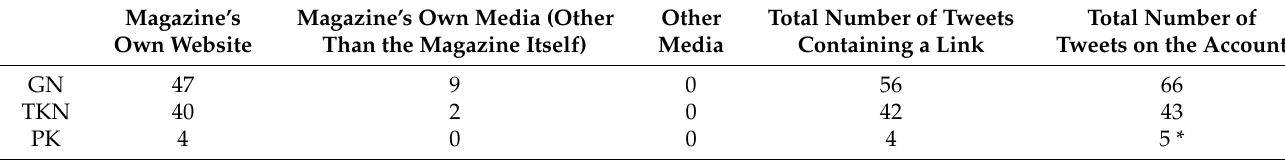
Table 9. The published links (N = 103) transfer to.